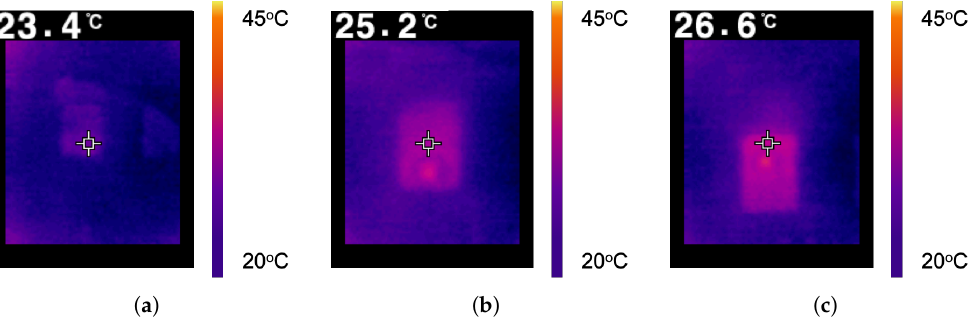
Figure 12. IR image of thermal pad ( a ) before operation, ( b ) after 30 min operation, ( c ) after 6 h operation.